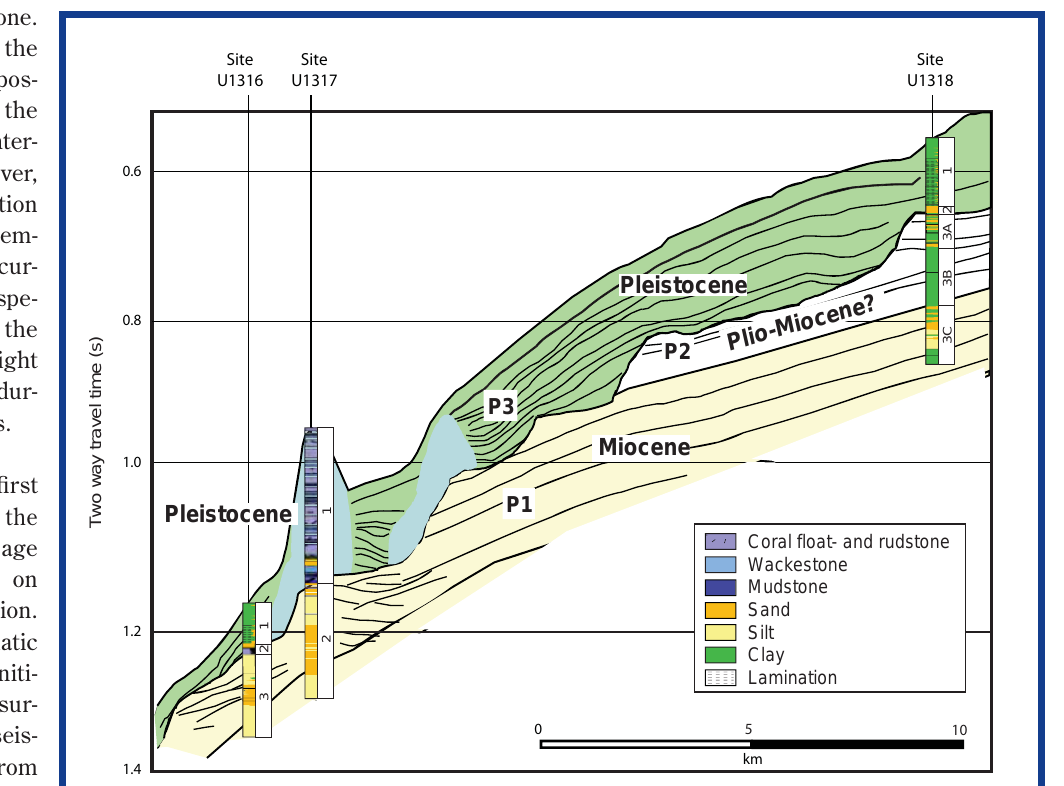
Figure 4. Lithostratigraphy of three drilling sites projected on seismic pro fi le of Challenger Mound along a north-northwest to south-southeast transect. Biostratigraphic dates for the 150-m thick mound sequence (blue) suggest that mound growth initiated 1.95 Ma and ended before 0.46 Ma. Note that more recent, siliciclastic Pleistocene sediments have onlapped and slowly buried the older Pleistocene mound